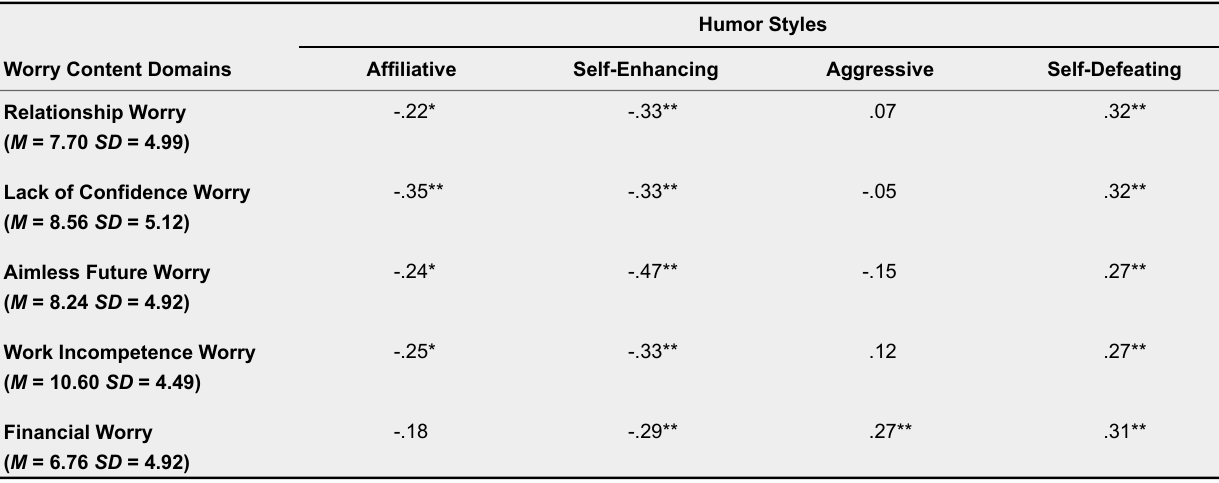
Correlations Between Humor Styles and Worry Content Domains.